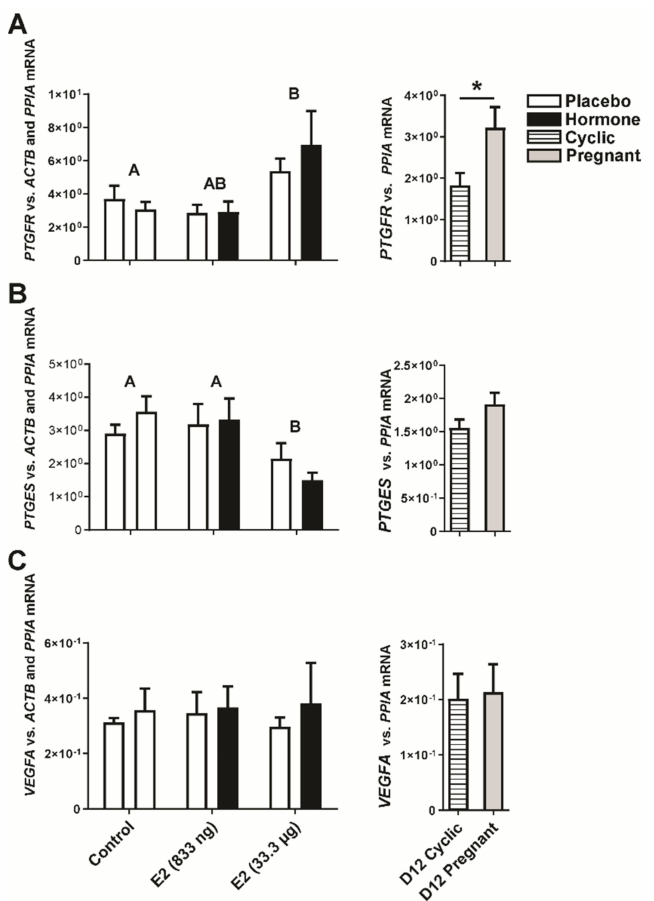
Figure 3. Expression of prostaglandin F2 α receptor ( PTGFR ; ( A )), prostaglandin E2 synthase ( PTGES ; ( B )) and vascular endothelial growth factor ( VEGFA ; ( C )) genes in the corpora lutea collected from estradiol-17 β (E2)- and placebo-treated gilts. Control—gilts receiving placebo infusions into both uterine horns. E2—gilts receiving infusions of either placebo into one randomly selected horn or E2 (833 ng or 33.3 µ g/infusion) into the contralateral horn. As referential groups, gilts on day 12 of the estrous cycle (D12 Cyclic) and pregnancy (D12 Pregnant) were included in analyses. Values of target gene expression were normalized against geometrical mean of ACTB and PPIA expression values (luteal samples from in vivo model) or PPIA expression values (luteal samples from day 12 pregnant/cyclic pigs). Main effect of treatment was detected on luteal expression of PTGFR and PTGES mRNA (E2-treated groups vs. the control group; p < 0.05). There was no significant effect of the site of hormone administration (i.e., the placebo-treated uterine horn vs. the hormone-treated uterine horn within the same animal) on luteal expression of PTGFR , PTGES, and VEGFA mRNA. Data are expressed as the mean ± SEM. Different letters indicate statistically significant differences between control- and hormone-treated gilts ( p < 0.05). Asterisk indicate statistical differences between gilts on day 12 of the estrous cycle and pregnancy ( p <